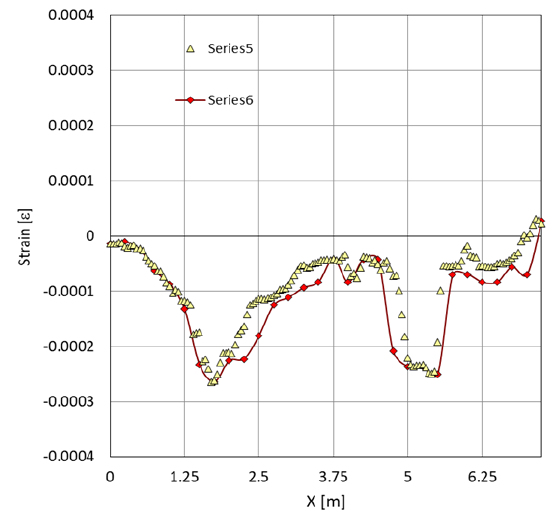
Figure 12. Strain diagram GG transducer.